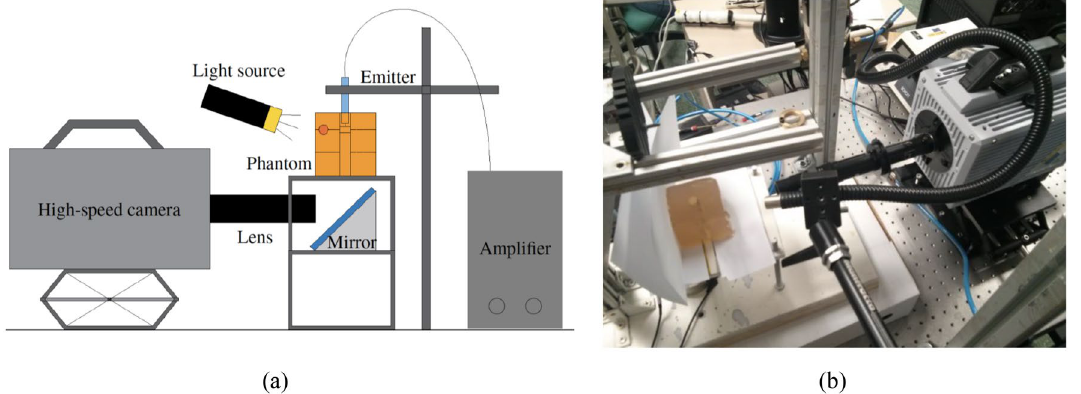
Figure 5. ( a ) Scheme of the setup for the HSC tests. The emitter (in blue) was held inside the phantom (in orange) through the lumen conduit. ( b ) Setup for the HSC tests. Phantom at the left side of the picture on top of the white platform. HSC and light source at the right side pointing towards the